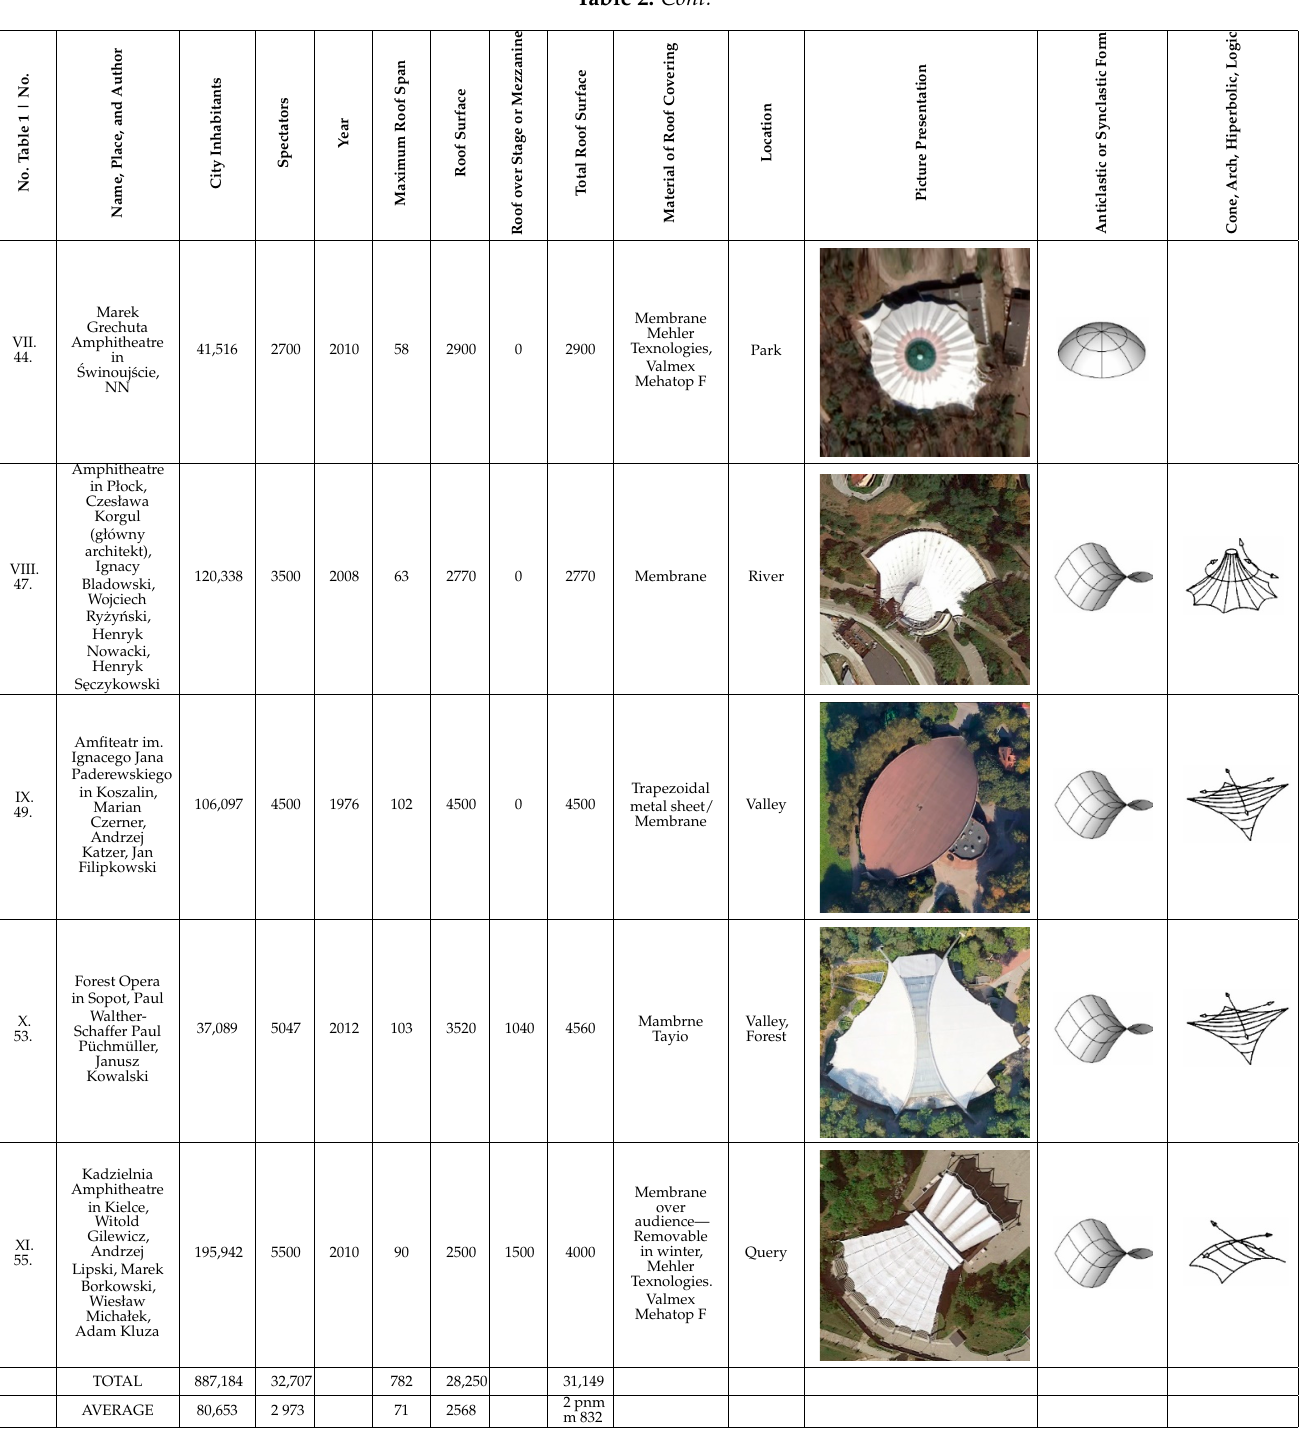
Related to this is the important issue of drainage of water from large surfaces at the lowest points of the canopy. In the case of homogeneous surfaces with a low degree of folding, there is a minimum number of drainage points. As a result, the highest accumu- lation of water per time unit occurs here, which requires an appropriate solution for its drainage without detriment to the structure and operation of the superstructure. In the analyzed examples, the smallest number of such points ranges from 2 in Szczecin to 38 in Biała Podlaska, where the roof surface is the most